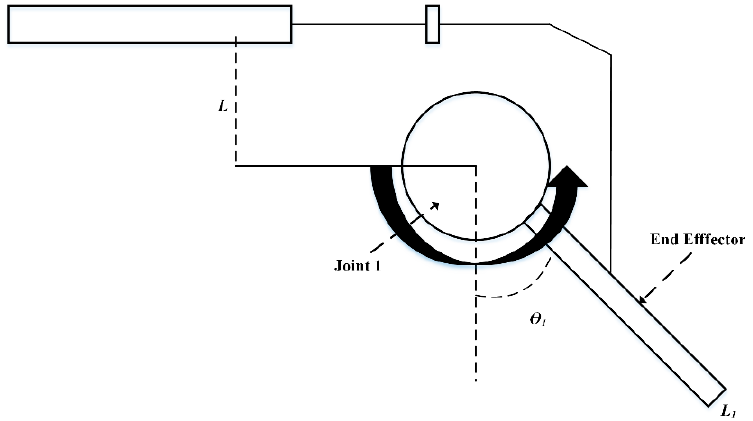
Figure 3. Schematic diagram of end effector.